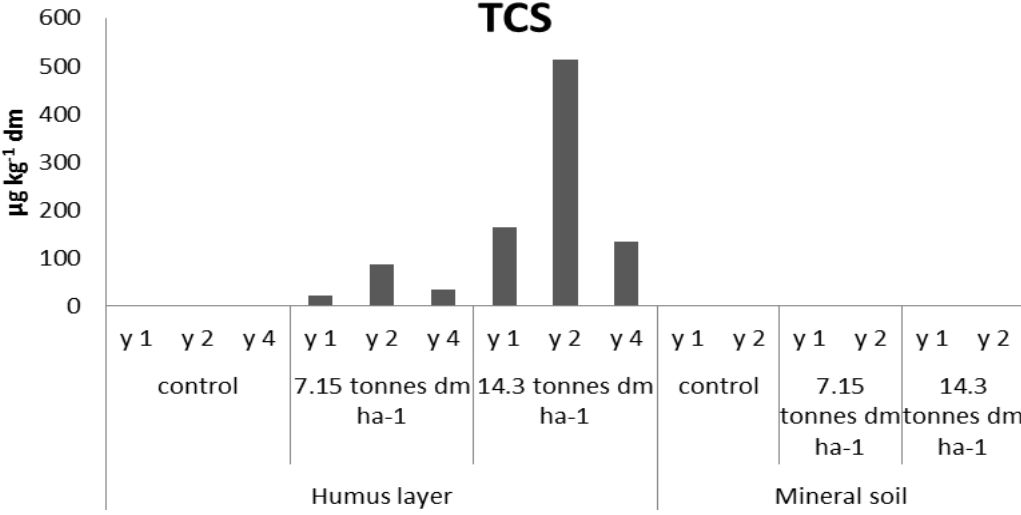
Figure 1. TCS levels in the small-scale experimental sites fertilized by hand (L1).